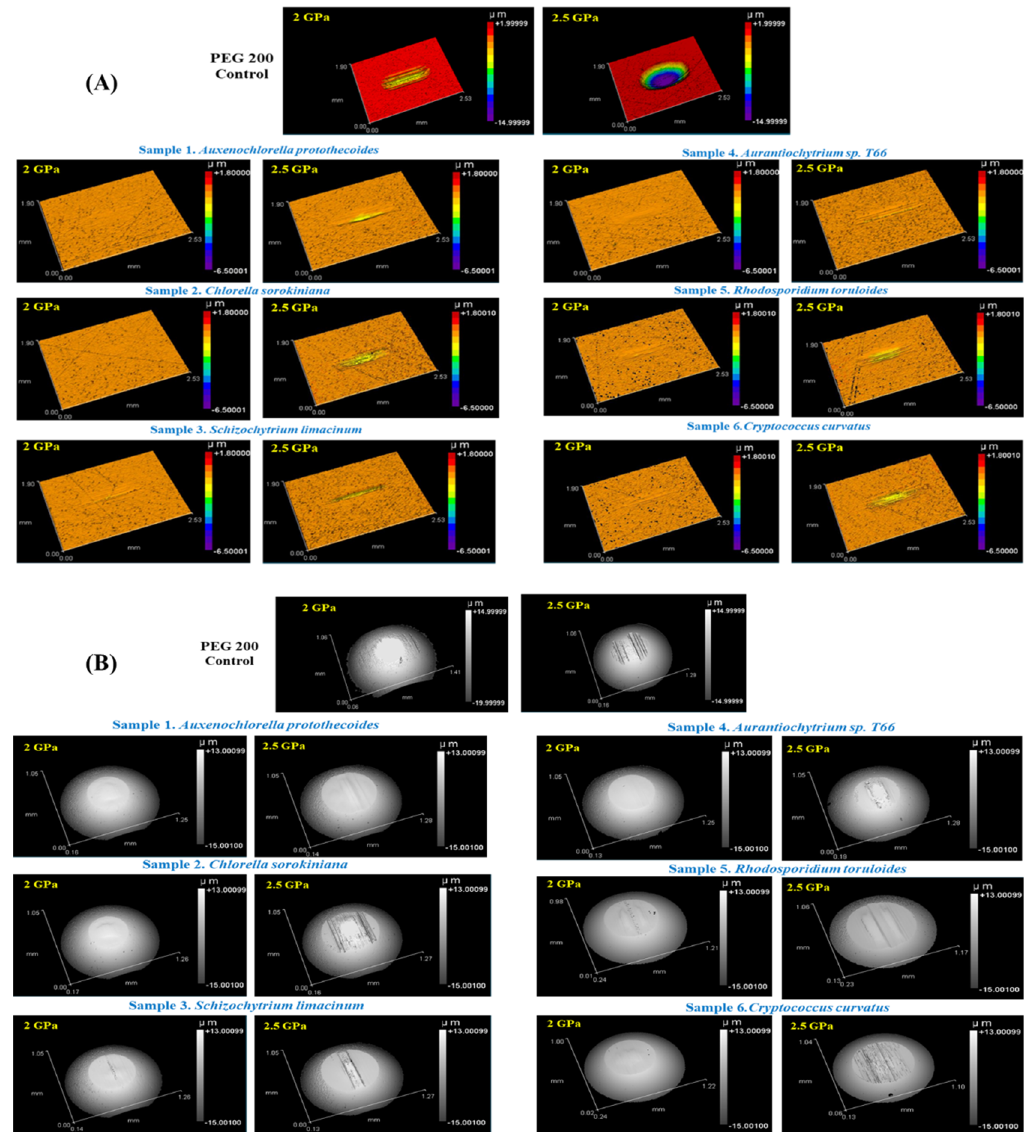
Figure 7. Three-dimensional surface images showing ( A ) disc wear and ( B ) ball wear of lipid samples and PEG 200 as controls at loads of 2.0 GPa or 2.5 GPa.